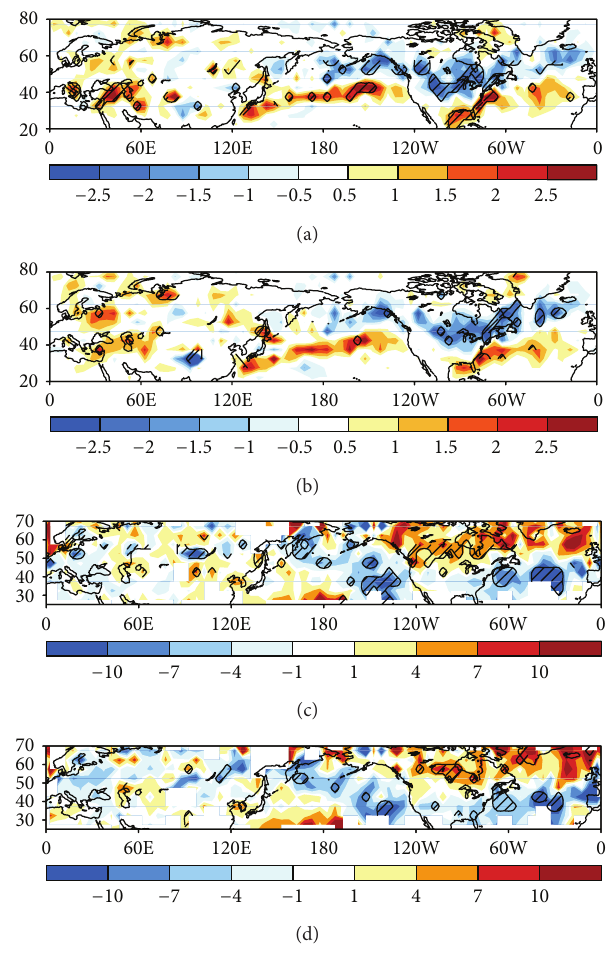
Figure 1: NH winter (JFM) El Ni˜no-La Ni˜na cyclone track frequency composite for (a) NCEP1 5801, (b) like (a) but for ERA40 5801. Units: no. of cyclones per 5 ∘ Lat × 5 ∘ Lon box. Hatched areas are significant at 90% for 2-tailed 𝑡 -test. (c) NH winter (JFM) El Ni˜no-La Ni˜na cyclone track intensity composite for NCEP1 5801. (d) like (c) but for ERA40 5801. Units: hPa. Hatched areas are significant at 90% for 2-tailed 𝑡